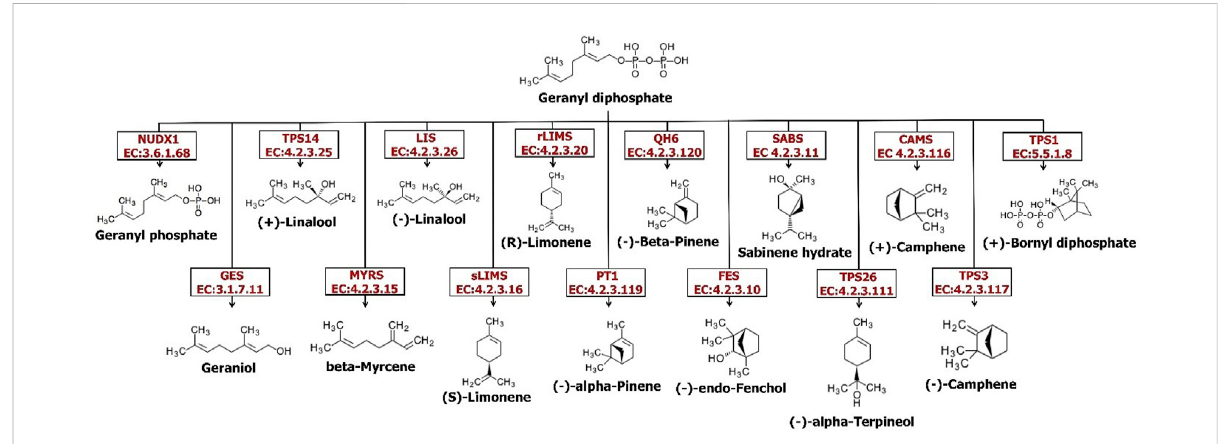
FIGURE 3 The monoterpenoids biosynthesis pathway in the Oliveria decumbens